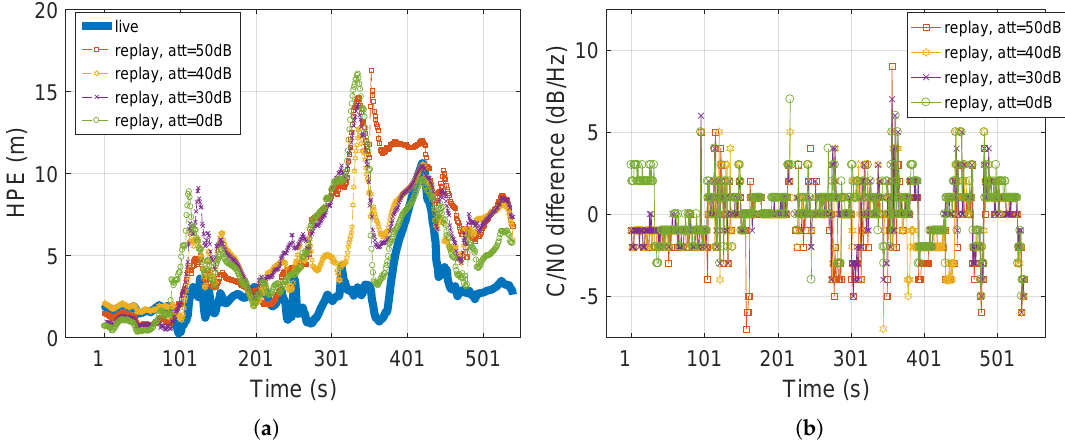
Figure 14. Test case for the urban environment. Different attenuation levels for the replayed signal. ( a ) HPE over time. ( b ) C / N 0 difference between live and replay signals for